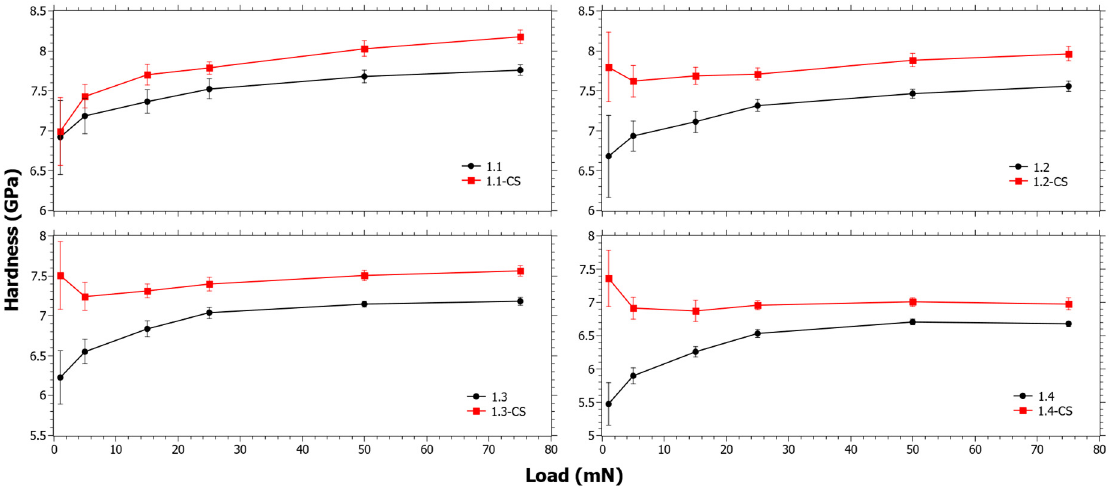
Figure 2. Nano-indentation hardness as a function load for Series 1 before and after chemical strengthening (CS).